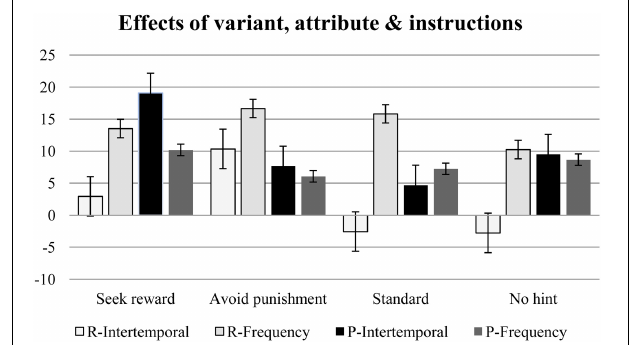
FIGURE A1 | The effects of four types of instructions on decision making in the reward variant were assessed via two attributes: intertemporal (C (cid:2) + D (cid:2) )—(A (cid:2) + B (cid:2) ) and frequency (B (cid:2) + D (cid:2) )—(A (cid:2) + C (cid:2) ); and the punishment variant was assessed via two attributes: intertemporal (E (cid:2) + G (cid:2) )—(F (cid:2) + H (cid:2) ) and frequency (F (cid:2) + G (cid:2) )—(E (cid:2) + H (cid:2) ). Error bars represent standard